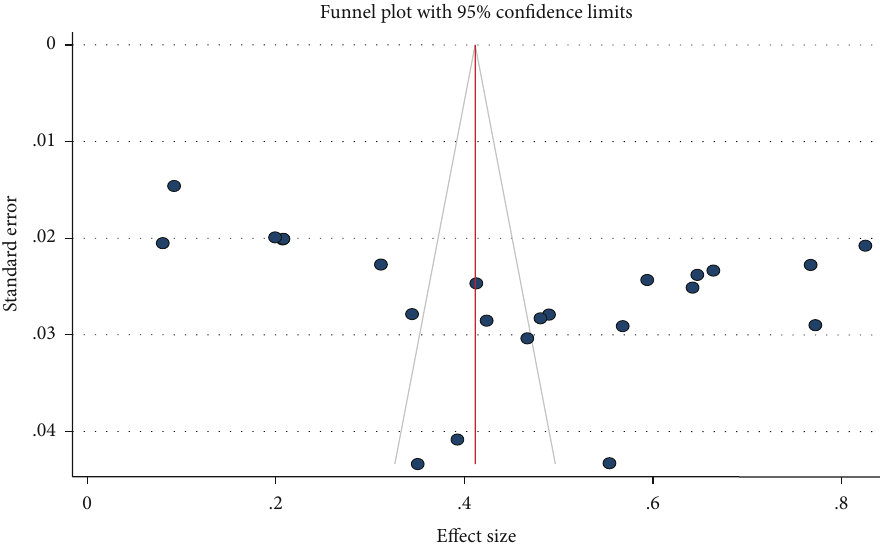
Figure 8: Funnel plot of the prevalence of controlled seizure